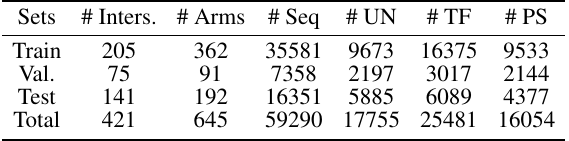
Table 1. Data for training, validation, and test. UN stands for uncontrolled, TF for traffic light, and PS for priority